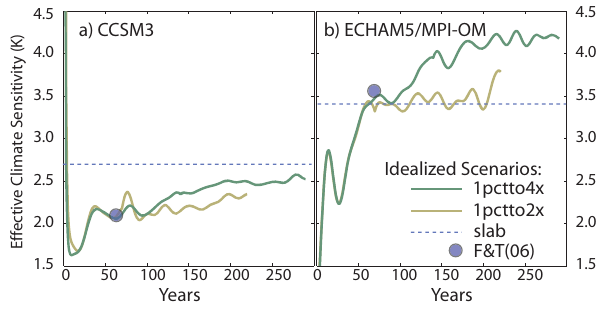
Fig. 1. The effective climate sensitivity diagnosed from low-pass filtered CCSM3 (a) and ECHAM5/MPI-OM (b) output for two ide- alized scenarios assuming an annual 1% increase in CO 2 concen- trations until twice pre-industrial values in year 70 (1pctto2 × ) or quadrupled concentration in year 140 (1pctto4 × ), with constant concentrations thereafter. Additionally, the reported slab ocean model equilibrium climate sensitivity (“slab”) and the sensitivity estimates by Forster and Taylor (2006) are shown